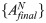
A flowchart of the algorithm for rigid registration of multiple bone images.The input of the algorithm is N 3D micro-CT images {I
N} and the index of the root image (I
Root; 1 ≤ Root ≤ N) to which all other images will be registered. (A) Preprocessing. For each input image I
N: 1. Zero-out all trabecular regions. 2. Zero-out all background regions. 3. Align bone to axes by applying PCA. 4. Extract cylindrical shape descriptor. (B) Pairwise Registration. For a pair of a source (I
s) and a target (I
t) image: 5. For each of the four basic alignments between the bones (with or without proximal-distal inversion × with or without right-left side inversion), calculate the affinity (Ψ) between the extracted shape descriptors of I
s and I
t as a function of the rotation angle (Θ) of I
t about PC1. 6. From each local optimum in the calculated affinity function, perform several volume-based registration steps using NCC as a similarity measure and downhill descent as the optimization method. 7. Identify the path that reached the highest NCC score and optimize it using additional volume-based registration steps until convergence is reached. 8. If NCC <0.7, perform manual validation of the registration. (C) Agglomeration of pairwise to multiple image registration and interpolation. 9. Sort and re-index all bones based on their lengths, from shortest (“1”) to longest (“N”). 10. Register all pairs of bones I
s, I
t (s < t) adhering to either one of the following criteria: I
s and I
t are lengthwise consecutive: t − s = 1 (subdiagonal entries in D; in blue), or t – s > 1 ∧ Length(I
t)/Length(I
s) ≤ 1.2 (non-subdiagonal entries in D; in green). Assign the resulting NCC score in the corresponding cell in D. 11. Calculate the MST of the graph inspired by D, with I
Root being the root of the tree. 12. Infer all final transformations (A
N) based on the MST. 13. Transform/interpolate each image I
N according to its inferred final transformation. The output is N 4 × 4 homogenous transformation matrices {AfinalN}, each aligns the corresponding input image I
N to the root image I
Root, and the N transformed images. For more details, see Materials and Methods.